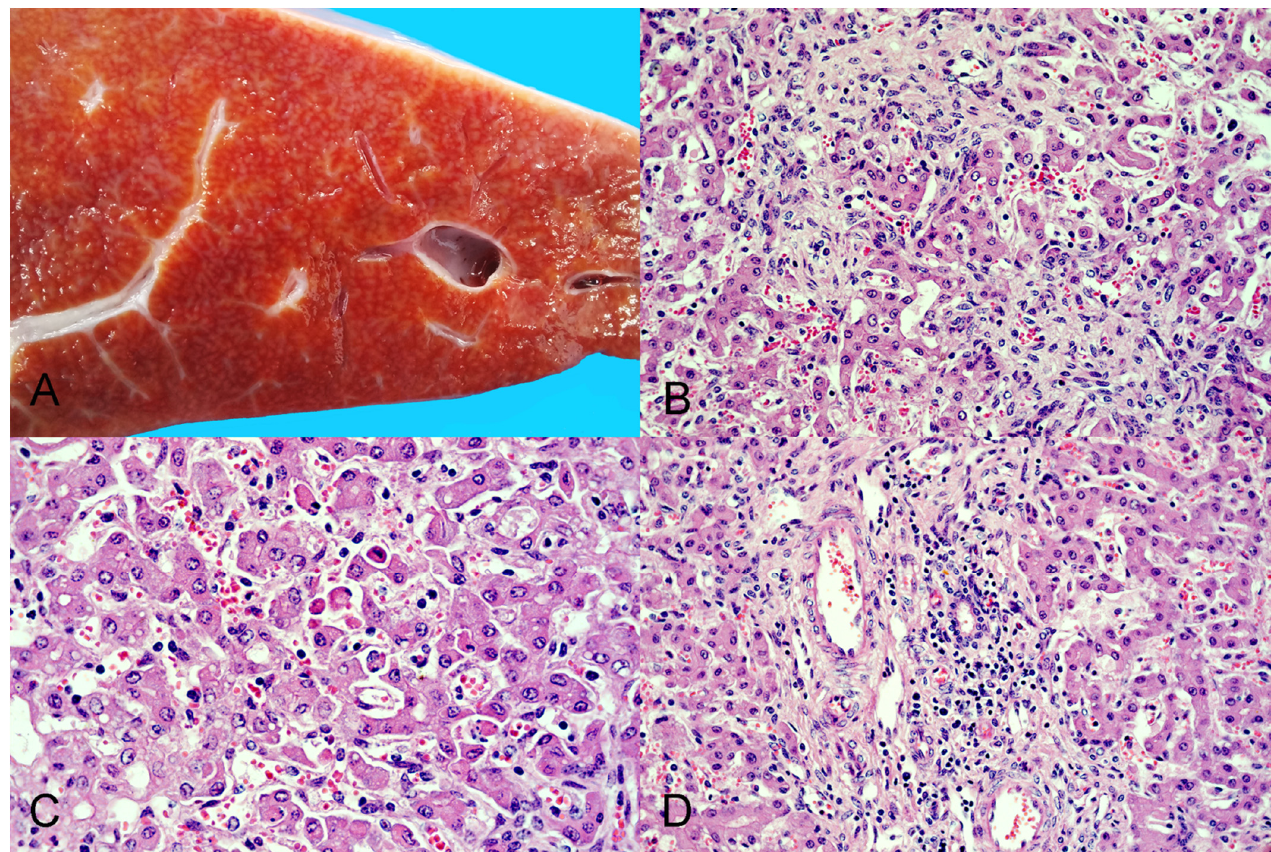
Figure 2. Pathological findings in the liver of the aborted fetus. ( A ) Cut section of the hepatic parenchyma showing an enhanced reticular pattern characterized by numerous pinpoint pale grayish foci and interconnected linear streaks alternating with reddish-orange areas of hepatic parenchyma (“nutmeg liver”). ( B ) The hepatic histoarchitecture is distorted and hepatic cords are disorganized and separated by areas of fibroplasia characterized by spindle cells (fibroblasts) embedded in a pale eosinophilic fibrillar (collagenous) extracellular matrix. HE stain, original magnification 400×. ( C ) Some hepatocytes are individualized and detached from the hepatic cords, and are shrunken, with angular cell borders, hypereosinophilic cytoplasm and pyknosis or karyorrhexis (hepatocellular necrosis/apoptosis); others have one or few clear intracytoplasmic vacuoles consistent with lipidosis. There are increased numbers of lymphocytes in the sinuses (hepatitis). HE stain, original magnification 630×. ( D ) A portal tract (center) is infiltrated by moderate numbers of lymphocytes and macrophages (portal hepatitis). HE stain, original magnification 400×.